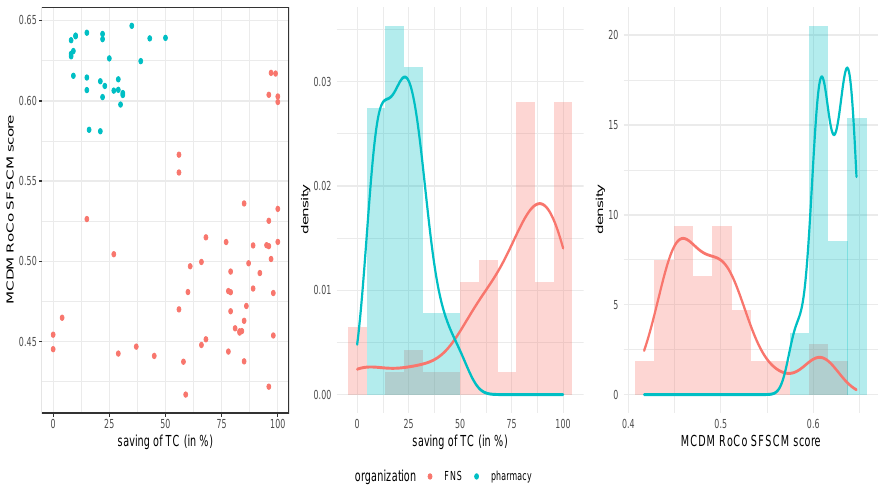
Figure 4. Scatterplot ( first panel ) and density plots ( second and third panels ) for saving of inventory cost (in %) versus MCDM RoCo SFSCM score (expressed as a proportion between zero and one) by organization.